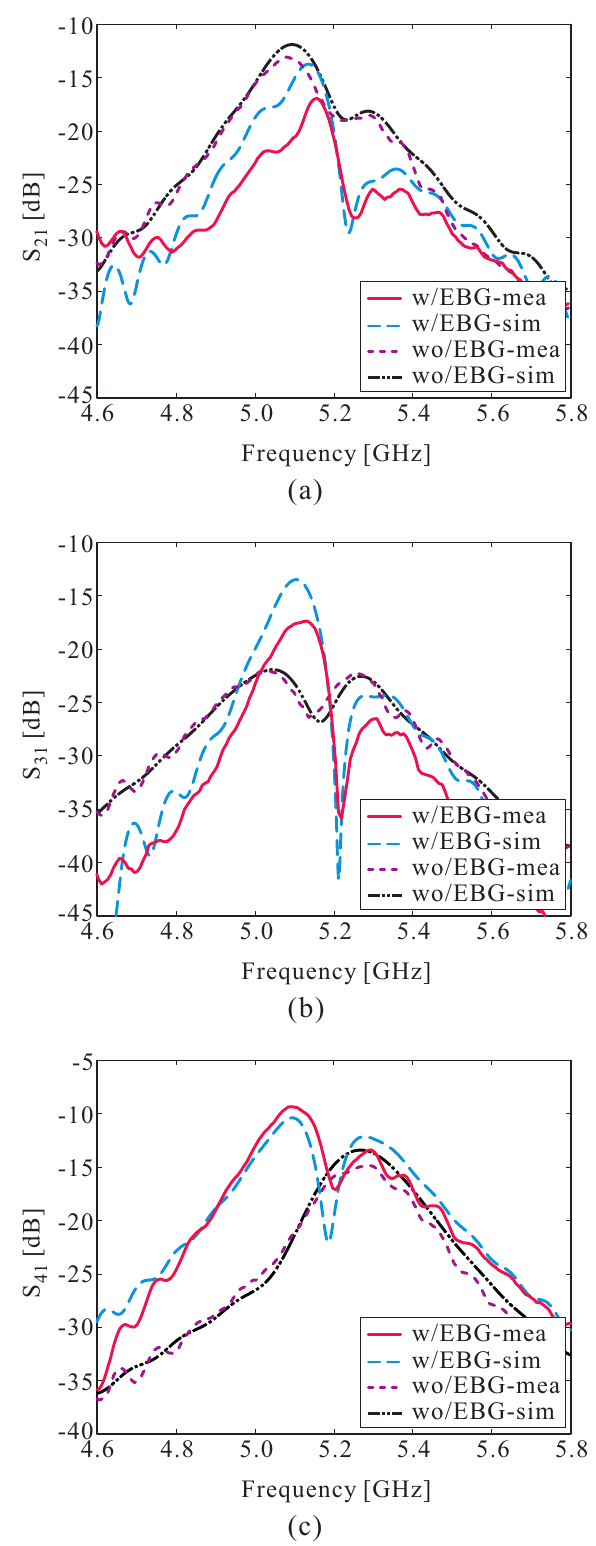
Figure 6. Measured and simulated results of ( a ) S 21 ; ( b ) S 31 ; and ( c ) S 41